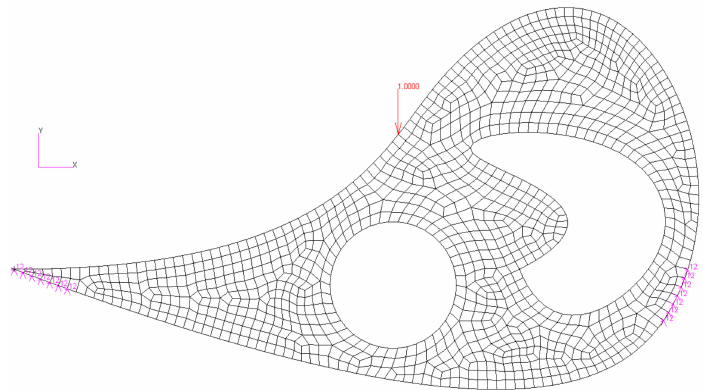
Figure 15. Discretization and constraints in FEM.